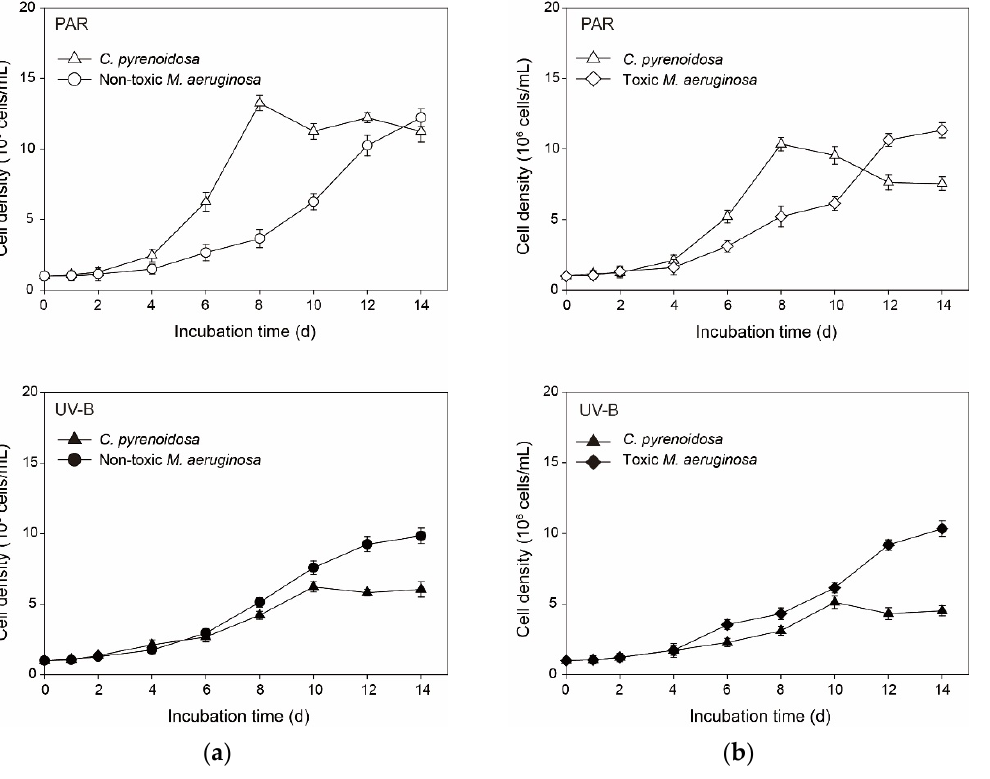
Figure 10. Cell densities of algal species in the co ‐ cultures of ( a ) C. pyrenoidosa & non ‐ toxic M. aeru ‐ ginosa , and of ( b ) C. pyrenoidosa & toxic M. aeruginosa in the PAR and UV ‐ B treatments under